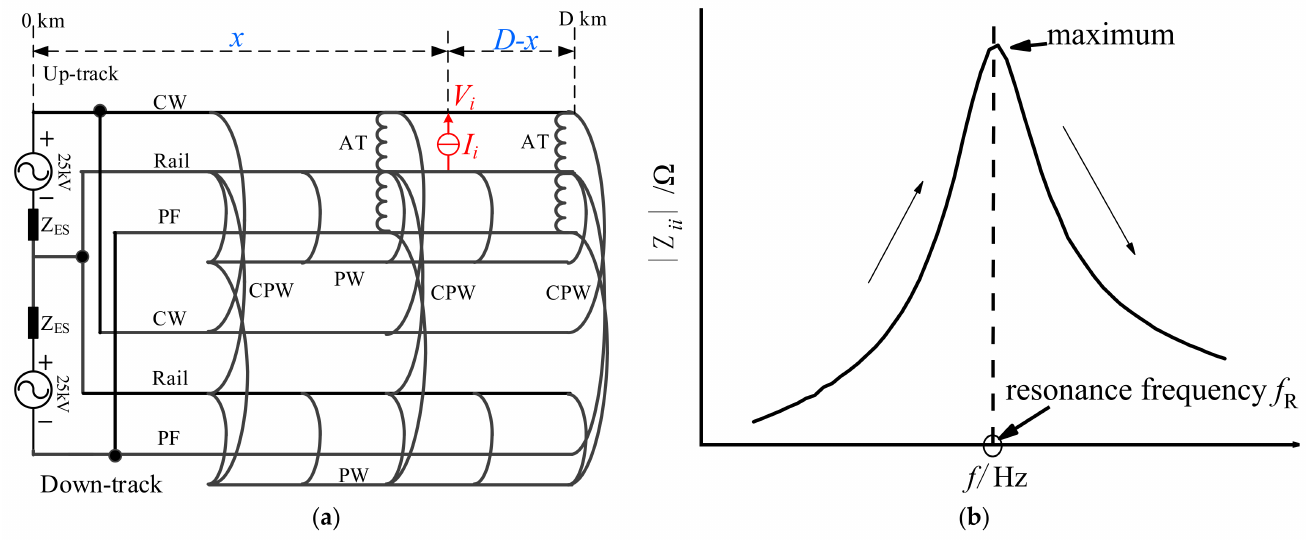
Figure 4. ( a ) Schematic of the resonance frequency identification × km from the substation. ( b ) Impedance–frequency curve of Z ii at position i (The slender arrow represents the change trend of